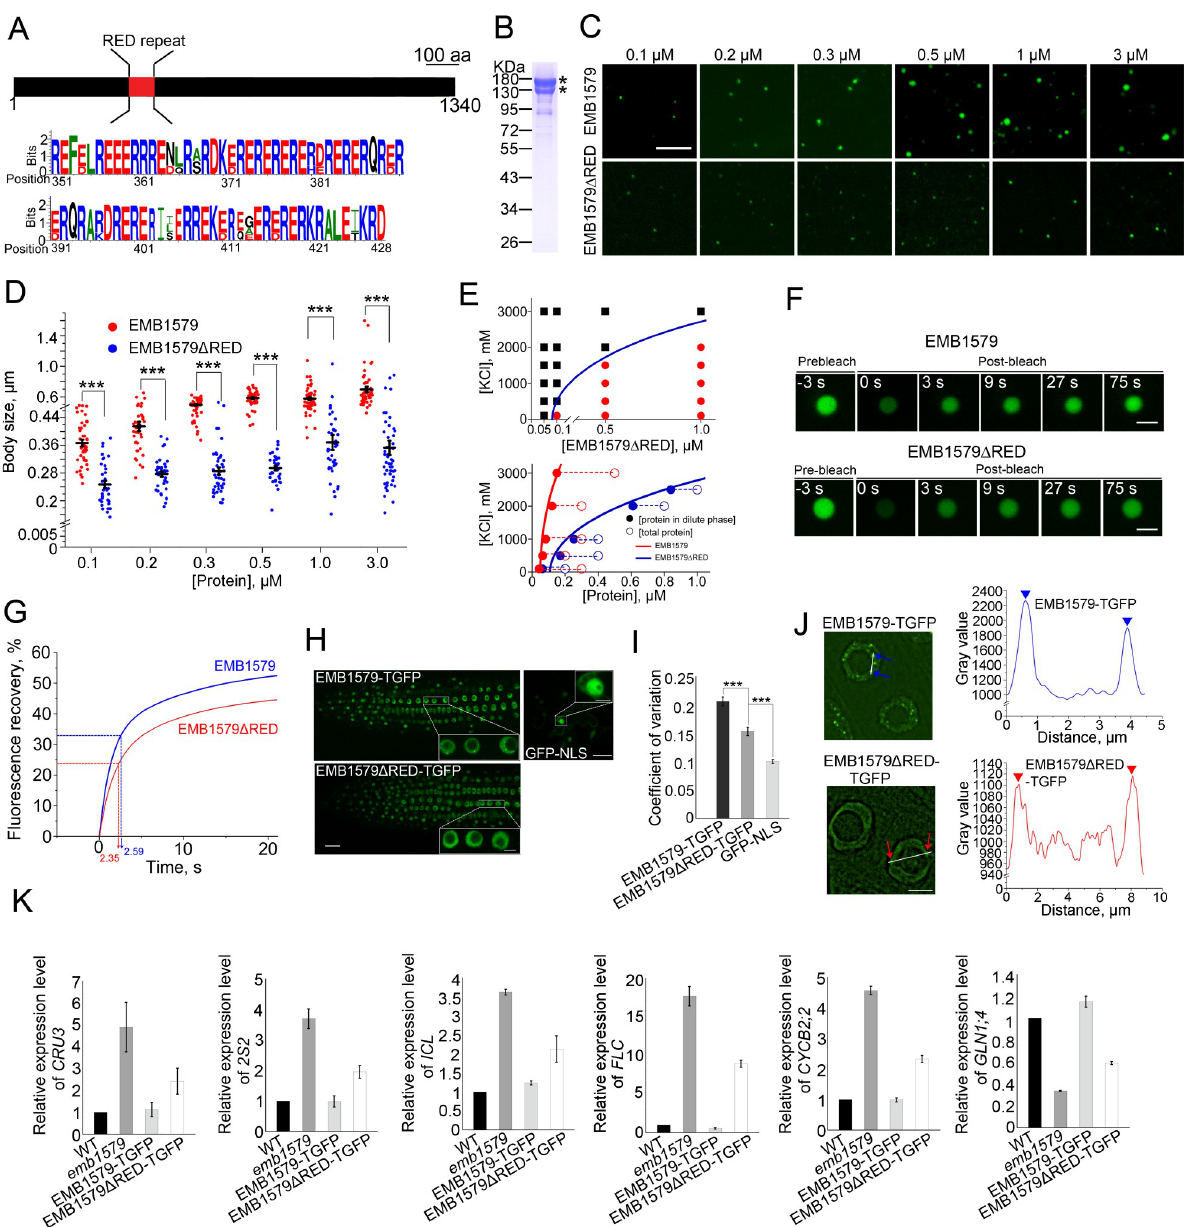
Fig 5. The RED repeat is crucial for the phase-separation property of EMB1579 in vitro and in vivo. ( A ) EMB1579 contains a RED repeat. The upper schematic shows the domain organization of EMB1579 and the lower panel is the sequence of the predicted RED motif in EMB1579, analyzed by WEBLOGO (http://weblogo.berkeley.edu/logo.cgi). ( B ) SDS-PAGE analysis of recombinant EMB1579 Δ RED. The asterisks indicate EMB1579 Δ RED protein bands. The original pictures are available in S1 Raw Images. ( C ) Representative fluorescence images of EMB1579 and EMB1579 Δ RED condensates formed under different concentrations. [EMB1579] and [EMB1579 Δ RED] range from 0.1 to 3 μ M. LLPS reactions were performed in F-buffer containing 100 mM KCl in the absence of PEG 3350. Bar = 5 μ m. ( D ) Quantification of the body size of EMB1579 and EMB1579 Δ RED condensates. Column scatter chart shows the body size in reactions containing [EMB1579] 0.1 μ M ( n = 42) and [EMB1579 Δ RED] 0.1 μ M ( n = 35), [EMB1579] 0.2 μ M ( n = 37) and [EMB1579 Δ RED] 0.2 μ M ( n = 39), [EMB1579] 0.3 μ M ( n = 41) and [EMB1579 Δ RED] 0.3 μ M ( n = 37), [EMB1579] 0.5 μ M ( n = 39) and [EMB1579 Δ RED] 0.5 μ M ( n = 45), [EMB1579] 1 μ M ( n = 51) and [EMB1579 Δ RED] 1 μ M ( n = 41), [EMB1579] 3 μ M ( n = 47) and [EMB1579 Δ RED] 3 μ M ( n = 50). Data are presented as mean ± s.e.m. ��� P < 0.001 by Student t test. Numerical data underlying this panel are available in S1 Data. ( E ) The capability of EMB1579 Δ RED to form condensates is impaired in vitro. The upper panel shows the phase diagram of EMB1579 Δ RED condensate formation at the indicated protein and KCl concentrations. The phase diagram was plotted as described in Fig 2L. Red circles indicate the formation of droplets; black squares indicate no formation of condensates. The blue line indicates the phase boundary of EMB1579 Δ RED. The lower panel shows the saturation curves for the phase separation of EMB1579 and EMB1579 Δ RED. The protein concentration in the dilute phase (solid circles) is plotted for various total protein concentrations (empty circles) at five different KCl